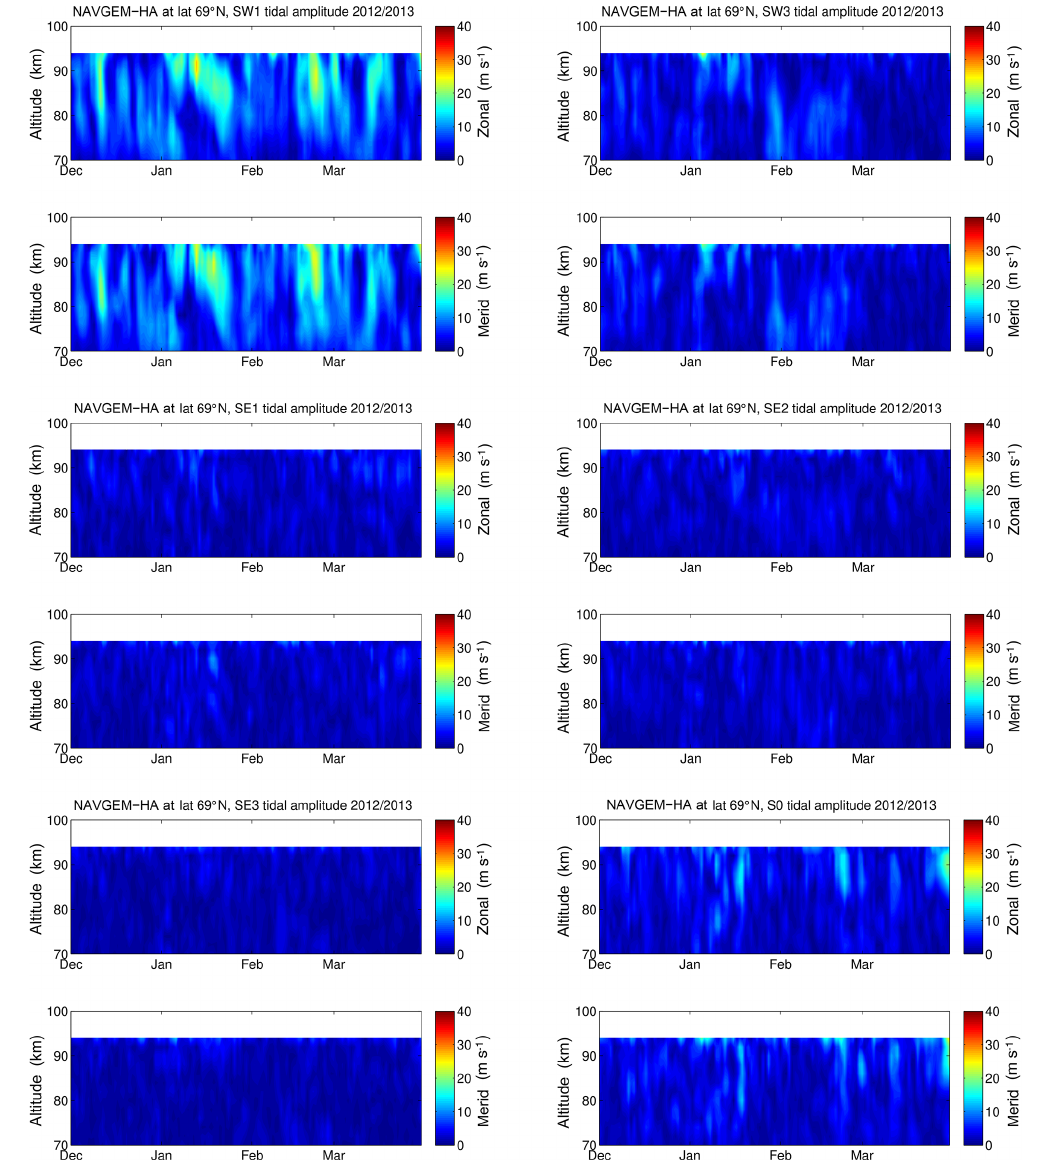
Figure B2. The same as Fig. 13 but for the winter of